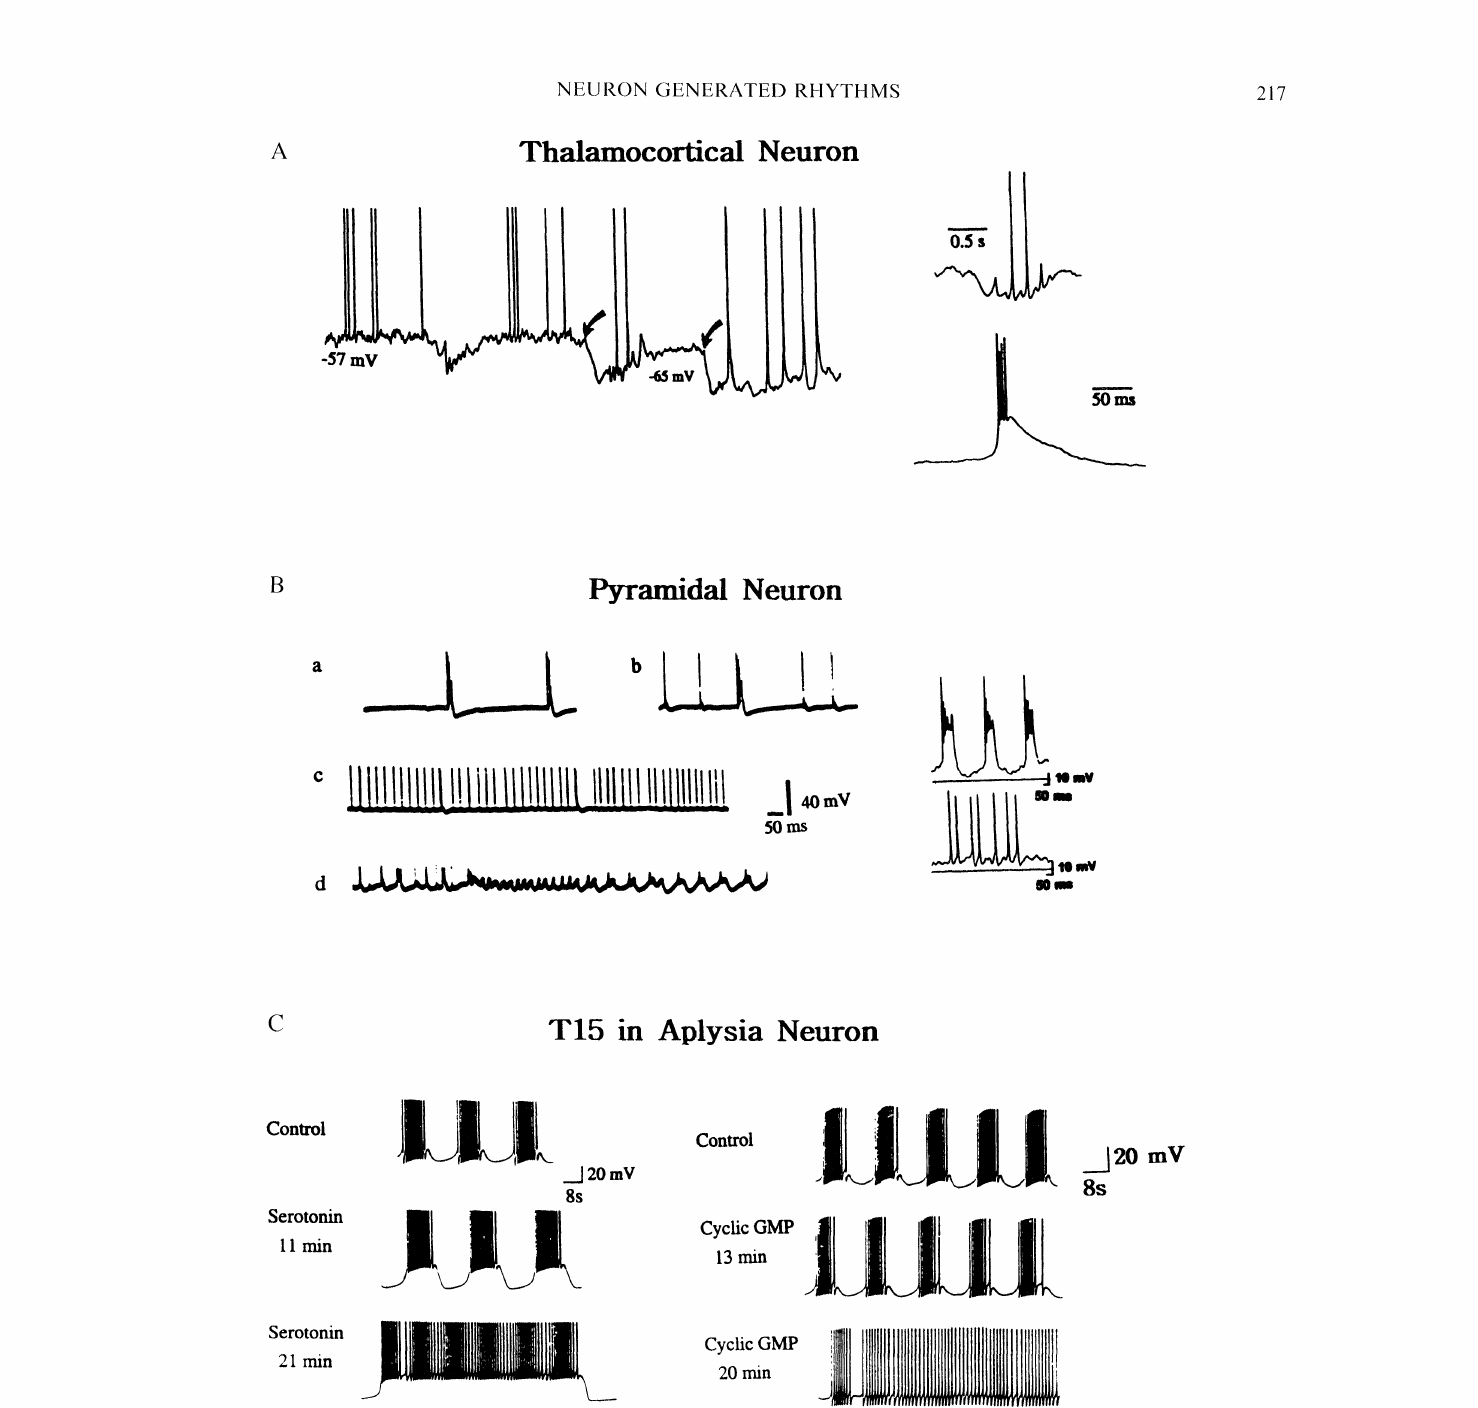
FIGURE 2 Endogenous bursting generated by thalamocortical lleurons (fi’amc A), pyramidal neurons (frame B), and T15 neuron ot" Al)13,xia o1" mollusc family (l’ralne C). Note that the former two bursters arc fast bursters with a bursting period of few hundred milliseconds, while the later is a slow burster with a period ot" few tens o1" seconds. In t’rame A, a hyperpolarizing current is applied at the first AI’I’OW, and a stronger hypcrpolarization current is applied at the second arrow. The insets show spindle (left) and delta (right) waves. In frame I3, a depolarization currcnl is increased from trace a to b, lo c, and finally to d. The top inset shows bursting in an expanded scale, and the bottom inset shows repetitive spiking. In frame C, scrotonin is applied steadily on the left, and cyclic GMP analog is applied steadily on the